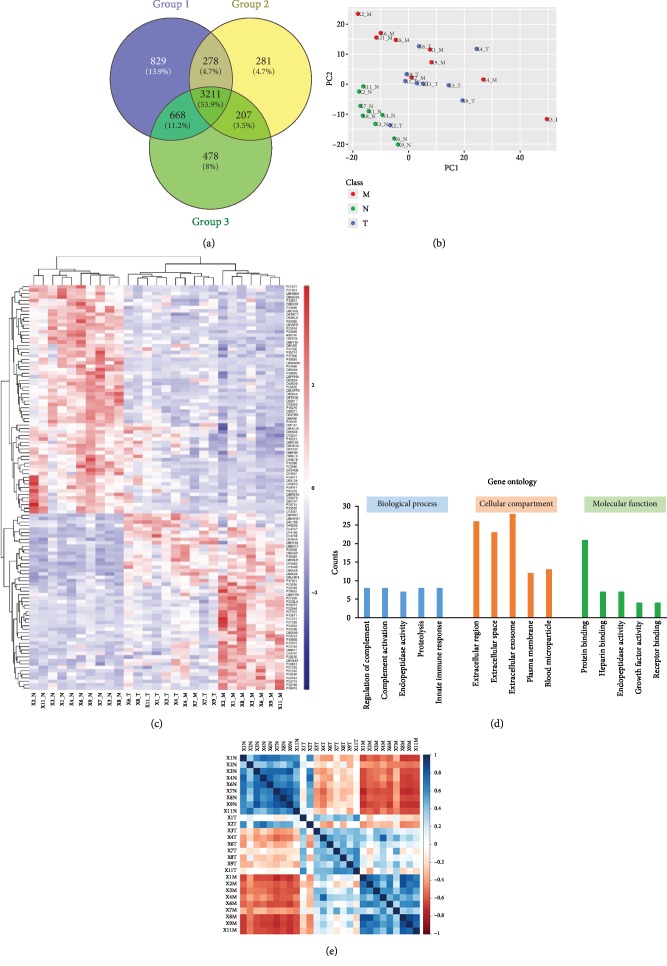
Overview of patient proteomic profiles, including normal colon (N), localized (T), and metastatic (M) CRC tissue types, as labeled at the end of each sample name. (a) Venn diagram of protein identifications from three different tissue types. (b) Principal component analysis (PCA) on the identified proteins from all samples revealed significant difference between normal colon (N) and localized (T)/metastatic (M) CRC. (c) Hierarchical cluster analysis on differentially expressed proteins among all samples. (d) Proteins with top significance (fold change > 2) were prioritized and annotated. Most of these proteins were from extracellular regions and participate in immune activities. (e) Correlation analysis of all samples. Results showed that proteomic profiles within normal tissue (N) samples were highly correlated. However, very poor correlation was found among metastatic samples which indicated the high heterogeneity of metastatic CRC.